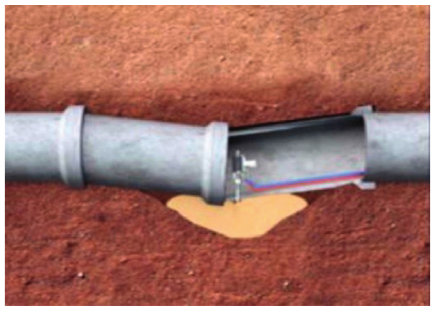
Figure 2: Polymer grouting lifts the settlement